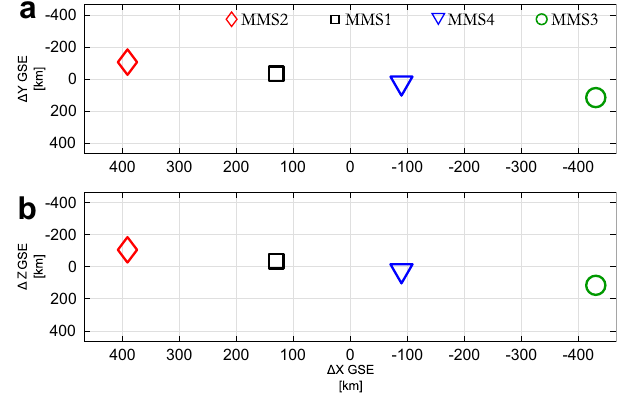
Fig. 1 Spacecraft formation for Magnetosphere Multiscale (MMS) 1 – 4. Spacecraft separation in the a xy plane and b xz plane in Geocentric Solar Ecliptic (GSE) coordinates. Note that the string-of-pearl con fi guration effectively provides an identical formation in the two